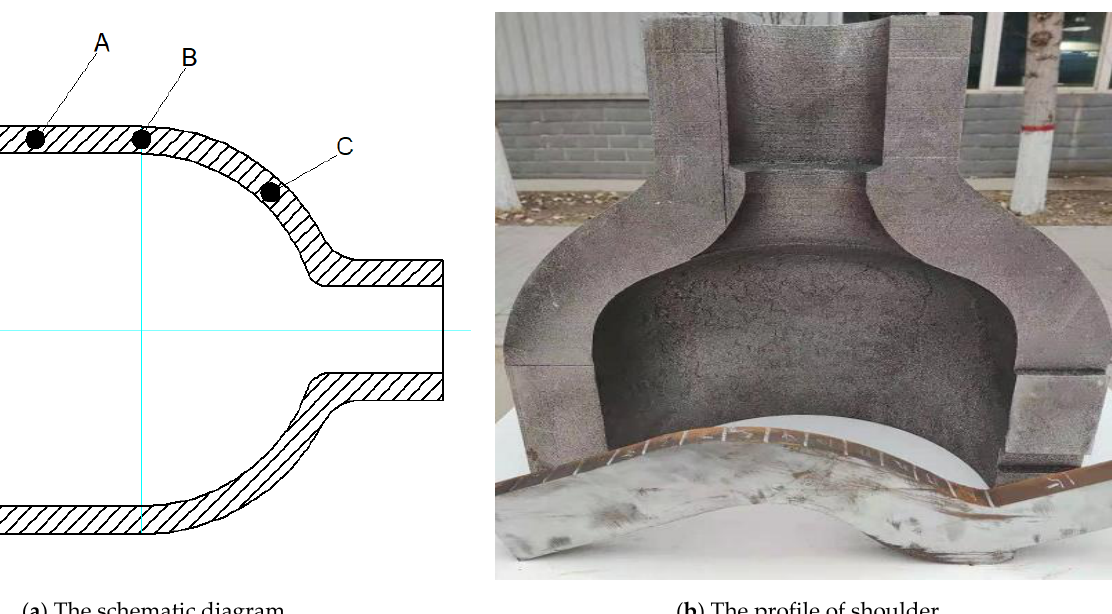
Figure 3. Sampling locations. The blue lines is center line.